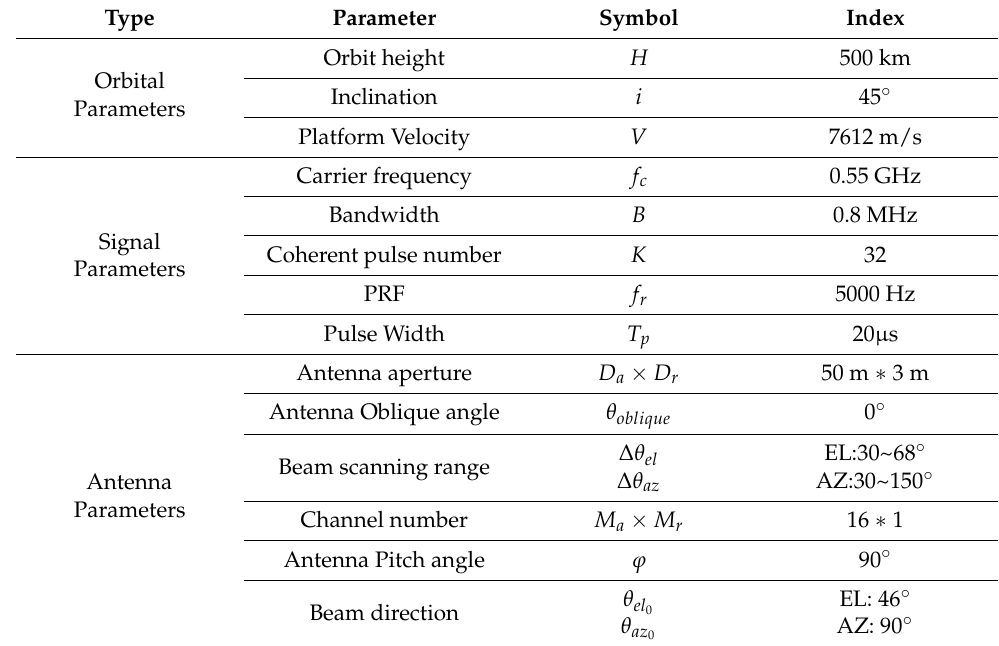
Table 1. Basic parameters of SBEWR used in this paper.